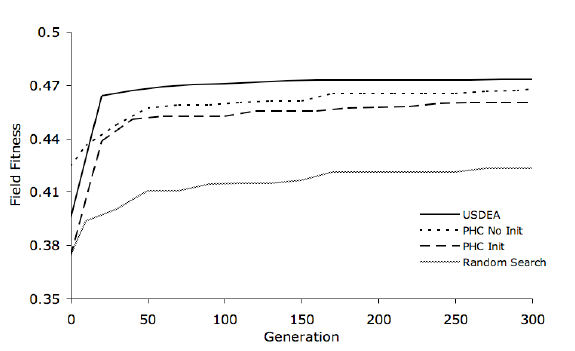
Fig.8. Benchmarking for a Cluster Field with an MNC of 5